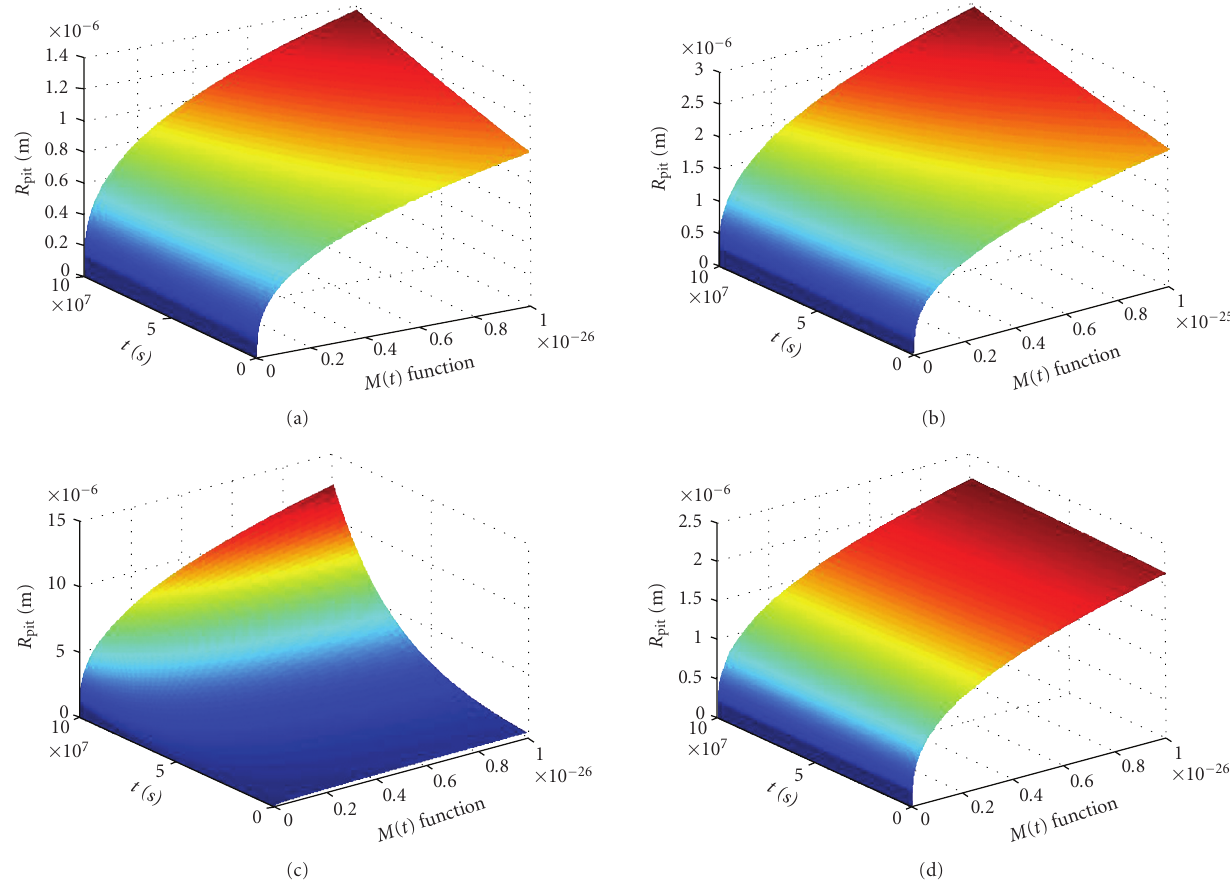
Figure 2: Simulations of time profile of pit radii for various parameters/functions. The range of M ( t ) various function: (a) M ( t ) ∈ (0,10 − 25 ), k M N im ∼ 10 − 8 , (b) M ( t ) ∈ (0,10 − 24 ), k M N im ∼ 10 − 8 , (c) M ( t ) ∈ (0,10 − 25 ), k M N im ∼ 10 − 7 , (d) M ( t ) ∈ (0,10 − 25 ), k M N im ∼ 10 − 9 . Preposition